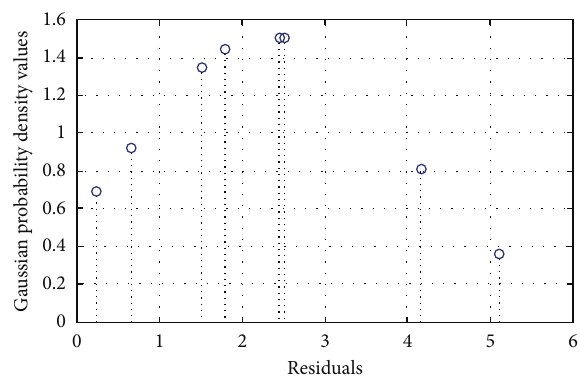
Figure 12: Gaussian probability density function of the residuals obtained from